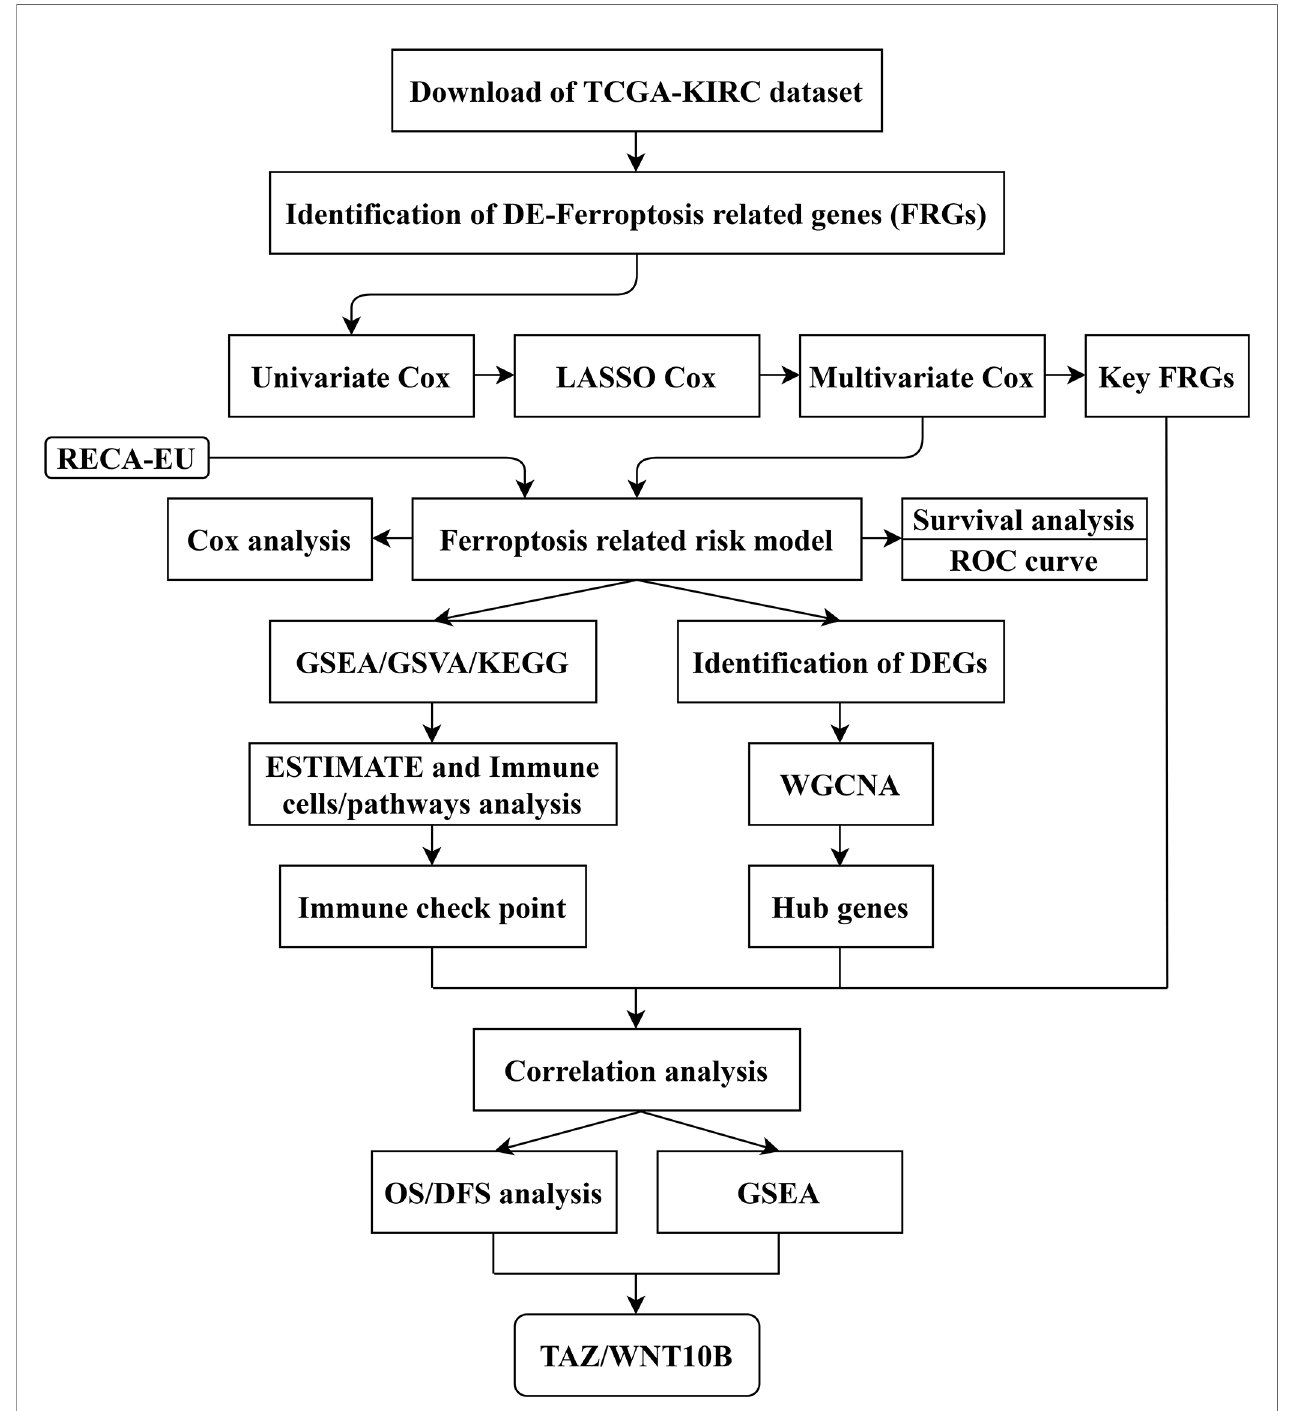
FIGURE 1 | Flow chart of study design. The data collection and study process were shown in a fl ow chart. TCGA, The Cancer Genome Atlas; KIRC, kidney clear cell carcinoma; FRGs, ferroptosis-related genes; LASSO, least absolute shrinkage and selection operator; ROC, receiver operating characteristic; GSEA, gene set enrichment analysis; GSVA, gene set variation analysis; KEGG: Kyoto Encyclopedia of Genes and Genomes; DEGs, differentially expressed genes; ESTIMATE, Estimation of STromal and Immune cells in Malignant Tumor tissues using Expression data; WGCNA, weighted gene co-expression network analysis; OS, overall survival; DFS, disease-free